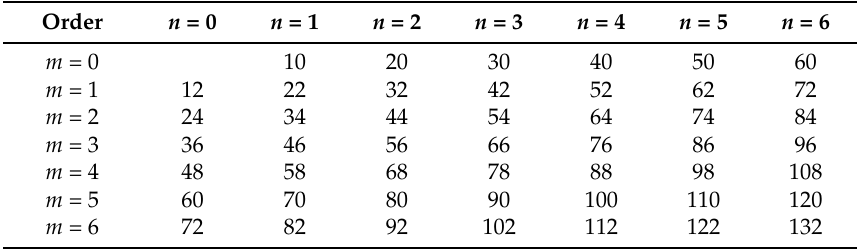
Table 3. Expected shaft order tones for a 12 × 10 F31/A31 model with equal rotor speeds.